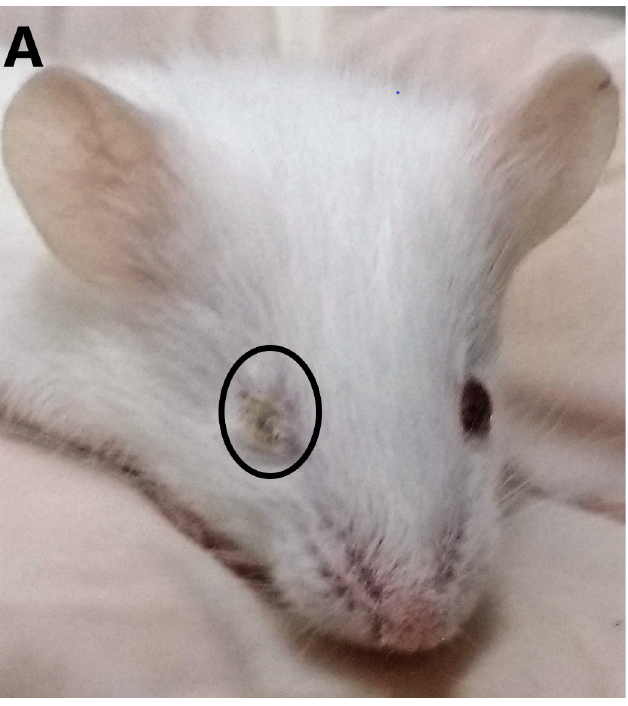
Fig 1. Balb/c mice with MAYV infected below the forelimb. Animals showing eye irritation and ruffled fur at 8 days post-infection. The irritation in the eye presented unilaterally, with